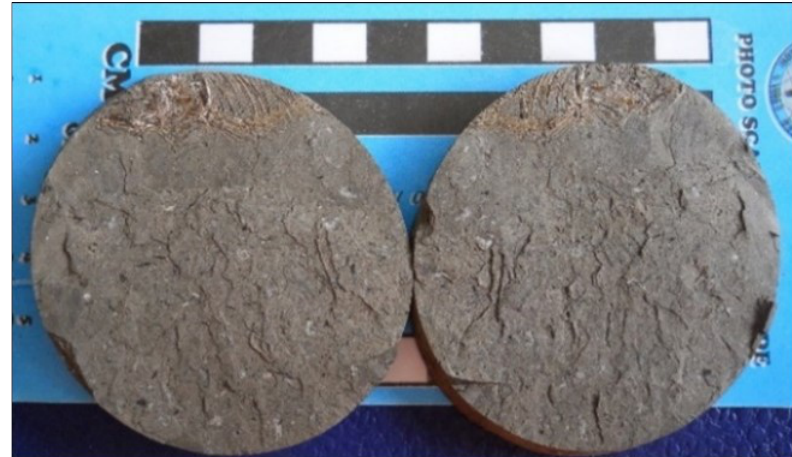
Fig. 10. View of drill core showing dark gray fish chord-bearing mudstone from the mid of sediment package on the northwestern limb of the Ergel-Khaliv section. Scale: